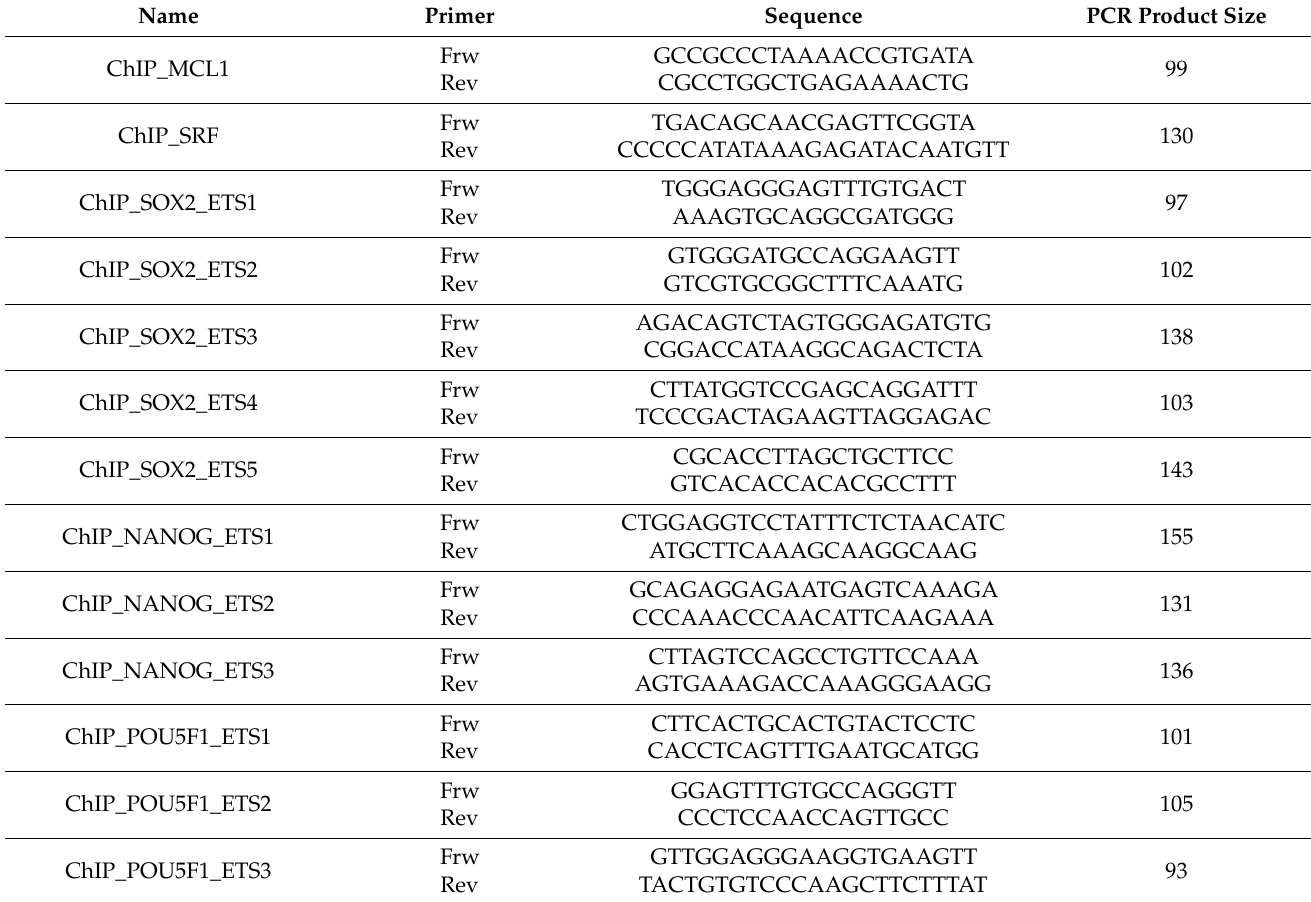
Table 5. The list of primers used in chromatin immunoprecipitation (ChIP)